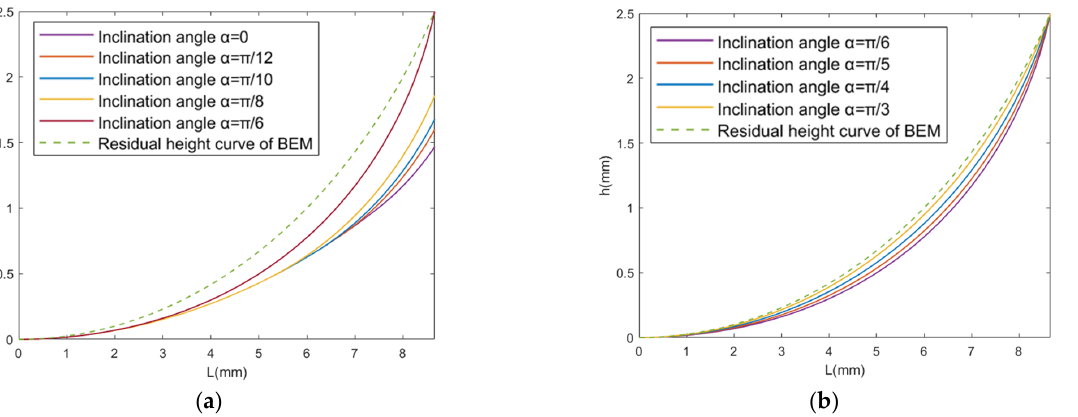
Figure 10. Relationship between L and h : ( a ) cutting contact point O’ is located on the bottom arc; ( b ) cutting contact point O’ is located on the ring arc.